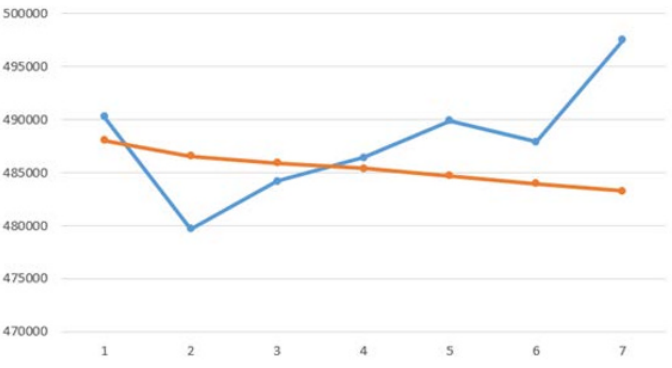
Fig. 6. Forecast power generation using ANN with the learning algorithm for the back propagation of